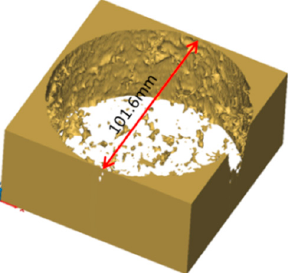
Figure 7. Diagram of Void Calculation.